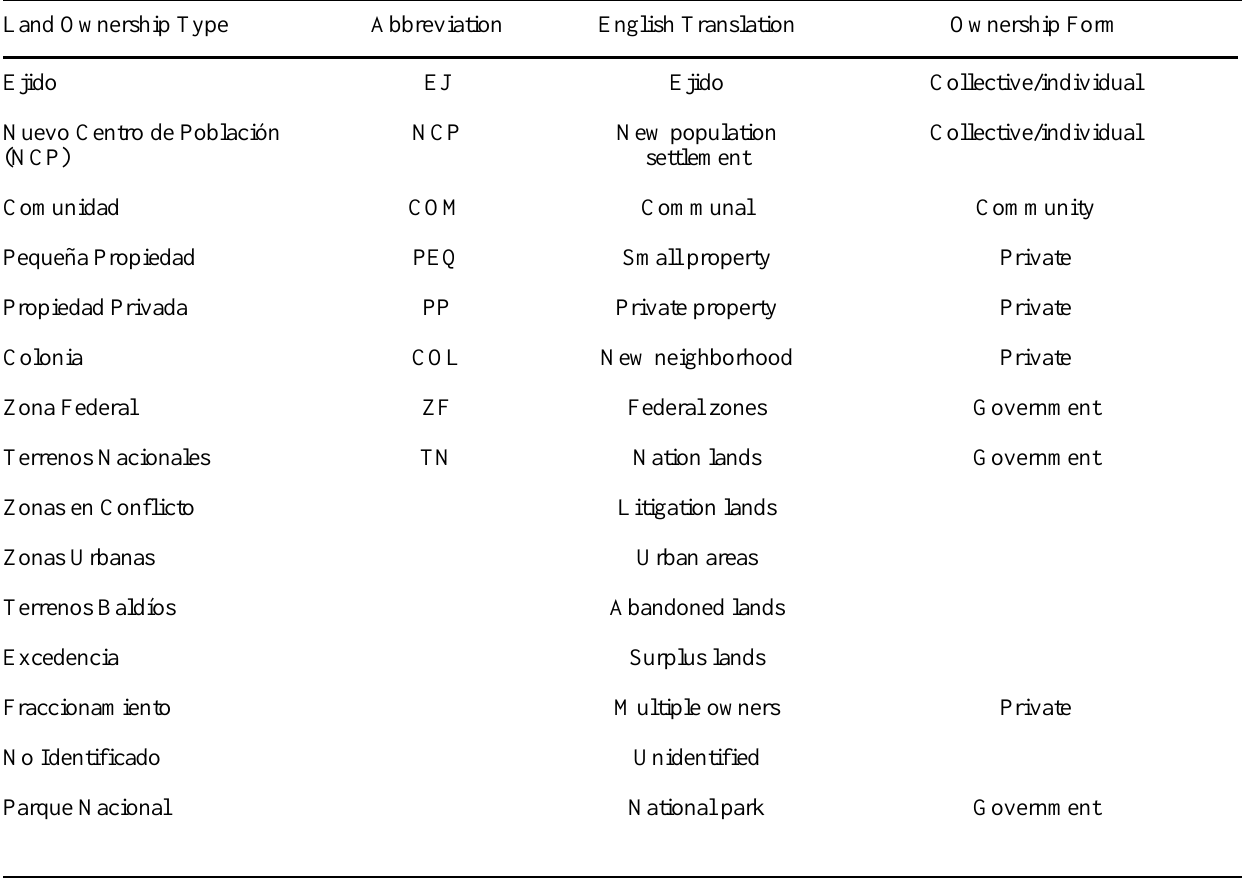
Table 2. Land ownership types provided by the Resgistro Agrario